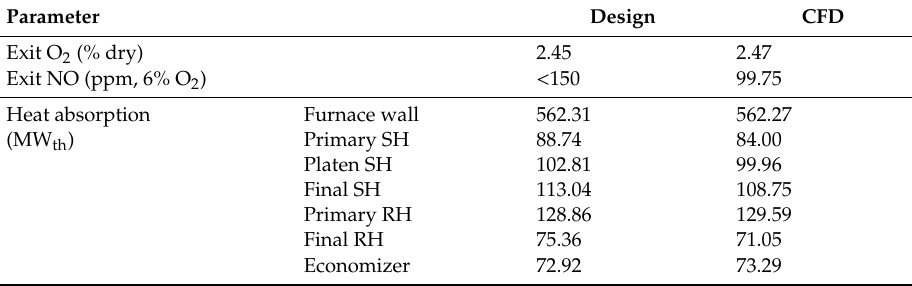
Table 4. Comparison of design data and CFD results for the reference